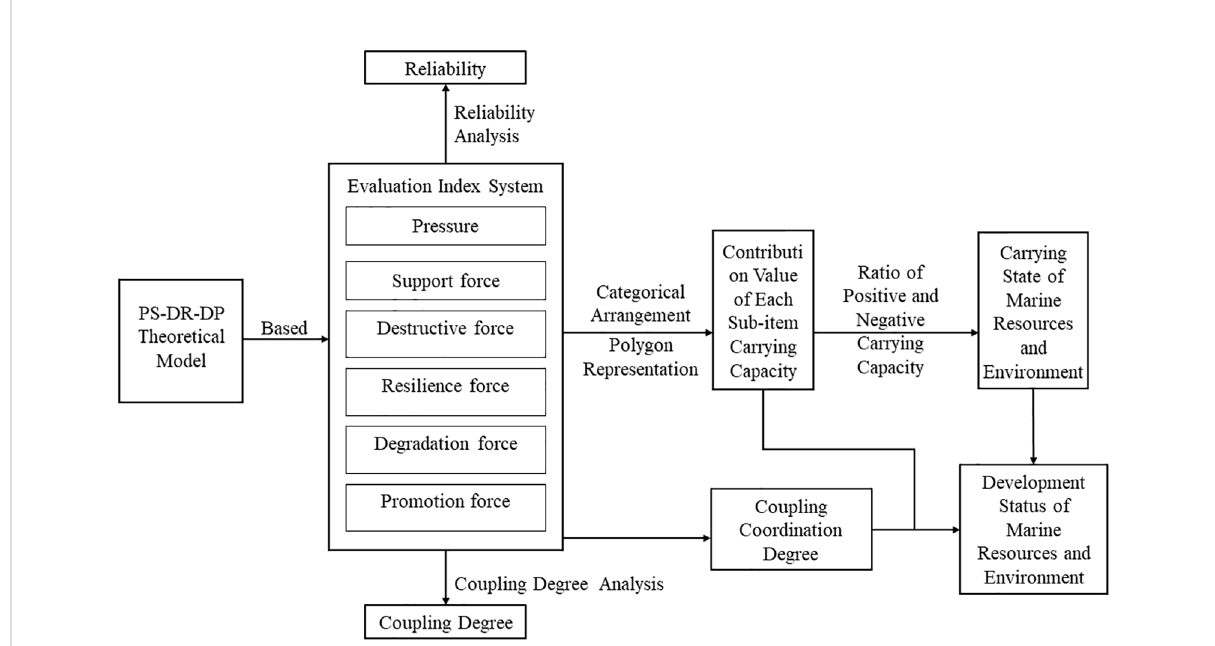
FIGURE 2 General idea of the marine resource environmental carrying capacity